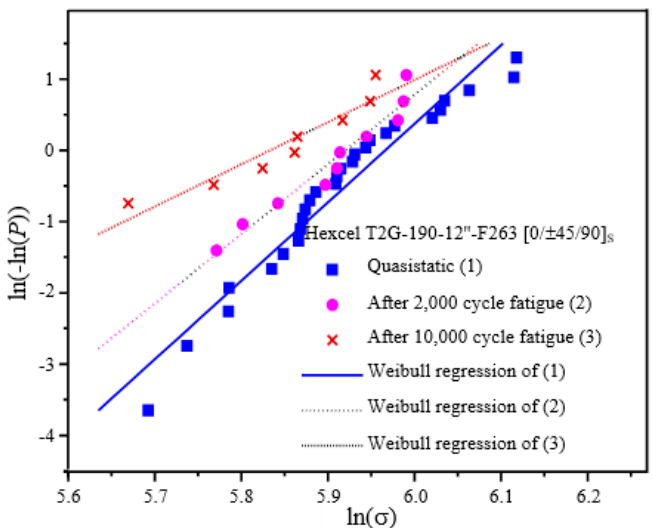
Figure 6. Variation of the survival probability with the residual tensile strength (in logarithmic scale).